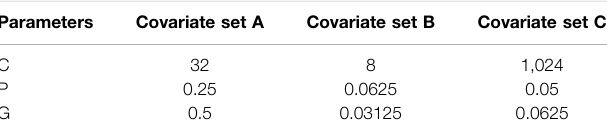
TABLE 4 | Parameters of SVM.